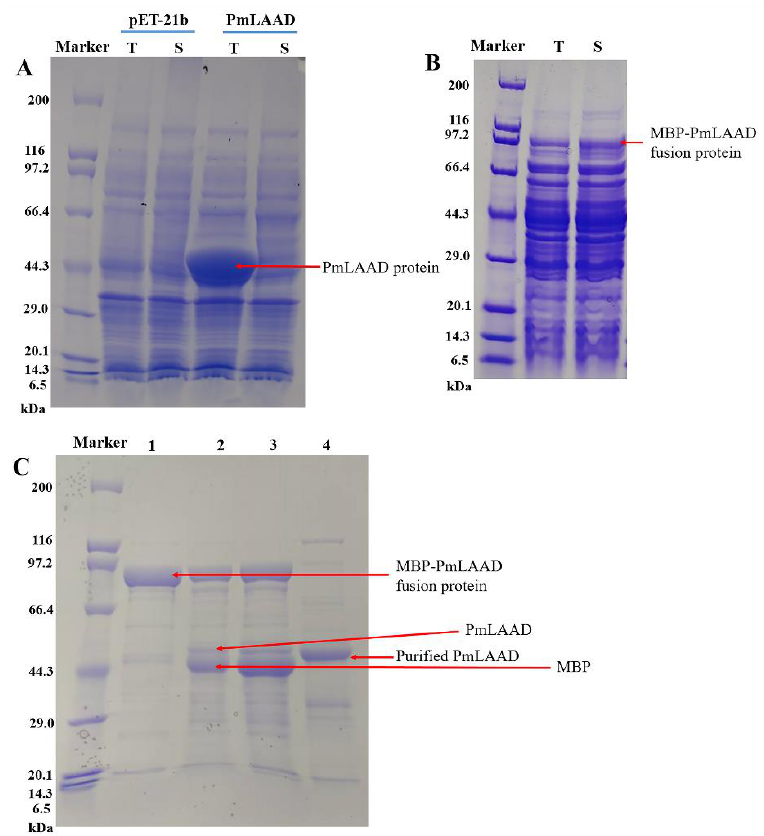
Figure 2. The SDS-PAGE of the PmLAAD and MBP-PmLAAD cell lysates and the purified MBP-PmLAAD. ( A ) E. coli BL21 (DE3) / pET-21b cell lysate (pET-21b), total cell lysate (T) and soluble fraction (S) of E. coli BL21 (DE3) / pET-21b-PmLAAD. The samples were generated from 50 mg / mL E. coli BL21 (DE3) / pET-21b cells and 50 mg / mL E. coli BL21 (DE3) / pET-21b-PmLAAD cells. ( B ) Total cell lysate (T) and soluble fraction (S) of E. coli BL21 (DE3) / pET-21b-MBP-PmLAAD. Lane T, E. coli BL21 (DE3) / pET-21b-MBP-PmLAAD cell lysate before centrifugation; lane S, E. coli BL21 (DE3) / pET-21b-MBP-PmLAAD cell lysate after centrifugation. The samples were generated from 50 mg / mL E. coli BL21 (DE3) / pET-21b-MBP-PmLAAD cells. ( C ) Purified and rTEV protease-treated MBP-PmLAAD fusion protein. Lane 1, proteins purified with Ni-column a ffi nity chromatography; lane